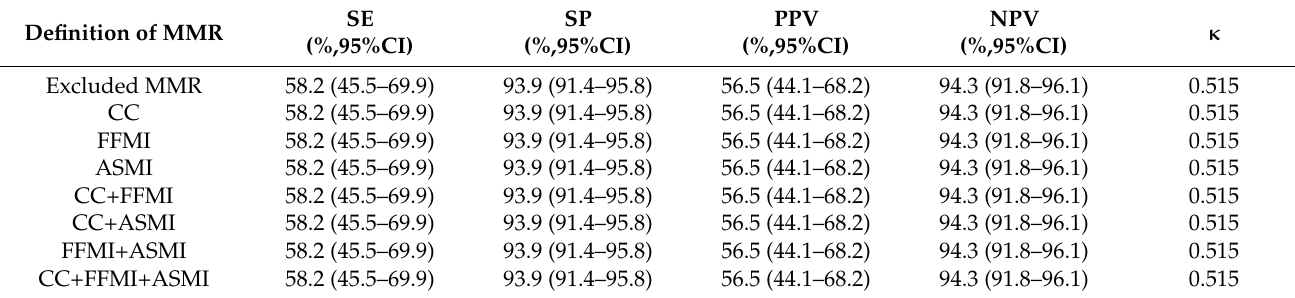
Table 5. SE, SP, PPV and NPV of GLIM using any combination of phenotypic and etiologic criteria in diagnosing severe malnutrition compared with